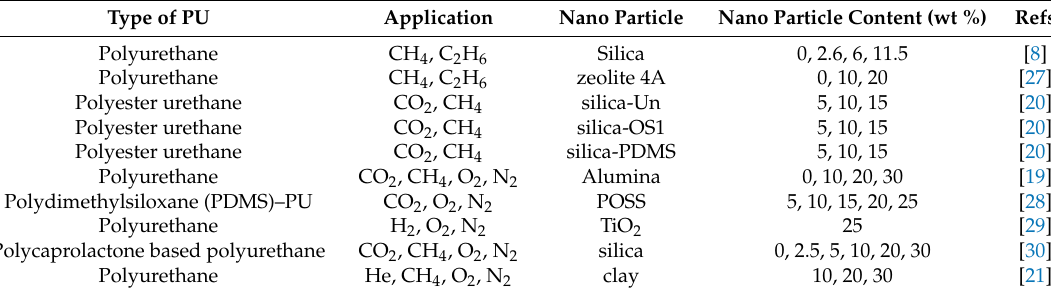
Table 1. PU MMMs with different nanoparticle for gas